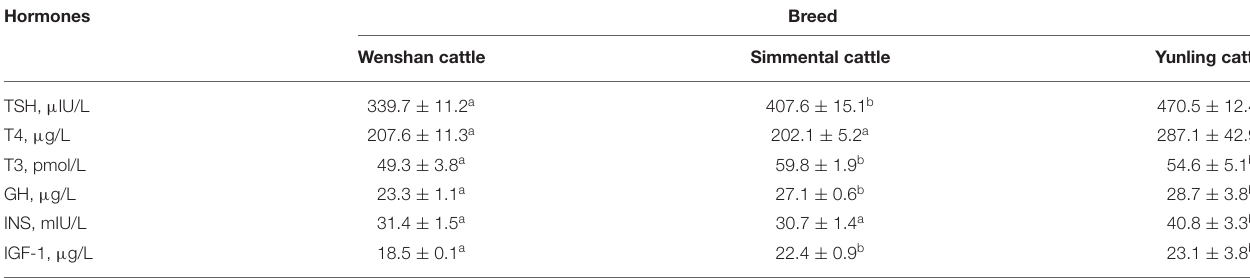
TABLE 3 | Growth hormone levels of three cattle breeds at the age of 18 months. Hormones